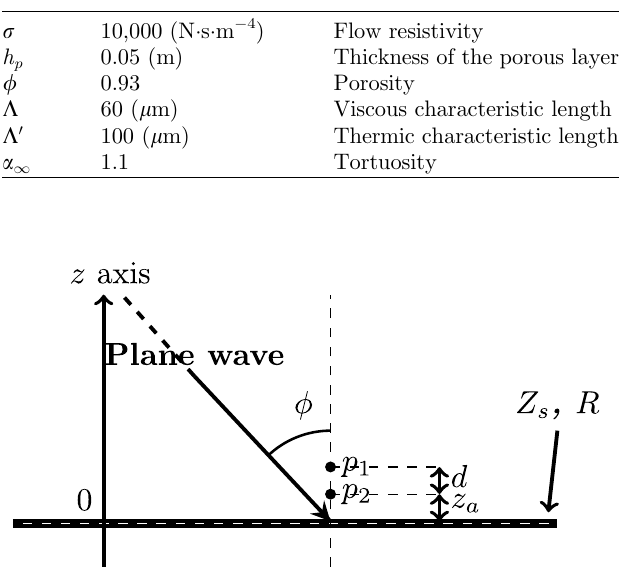
Figure 3. Diagram of the microphone pair with a plane wave incident on a sound absorbing plane of surface impedance